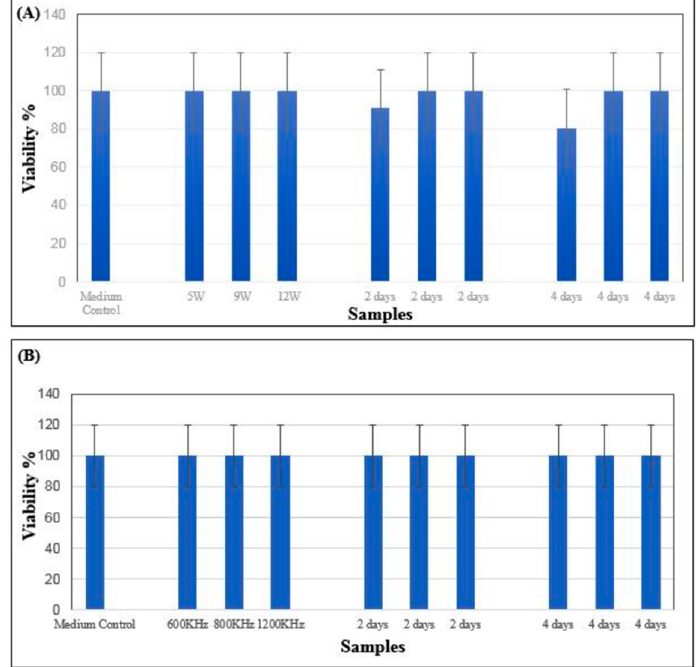
Figure 13. ( A ) MTT results of samples produced with different laser powers before and after immersion in SBF; ( B ) MTT results of samples produced with different laser frequencies before and after immersion in SBF.